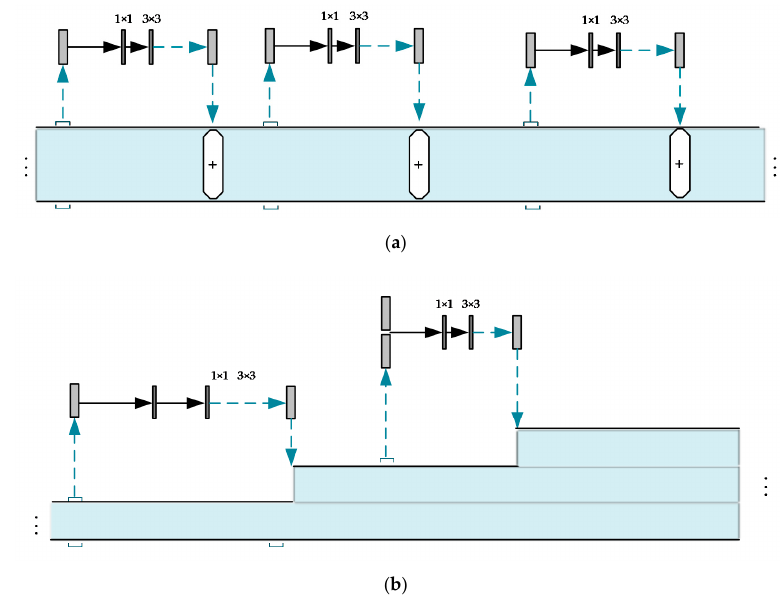
Figure 6. The architecture comparison of. ( a ) ResNet. ( b ). DenseNet.